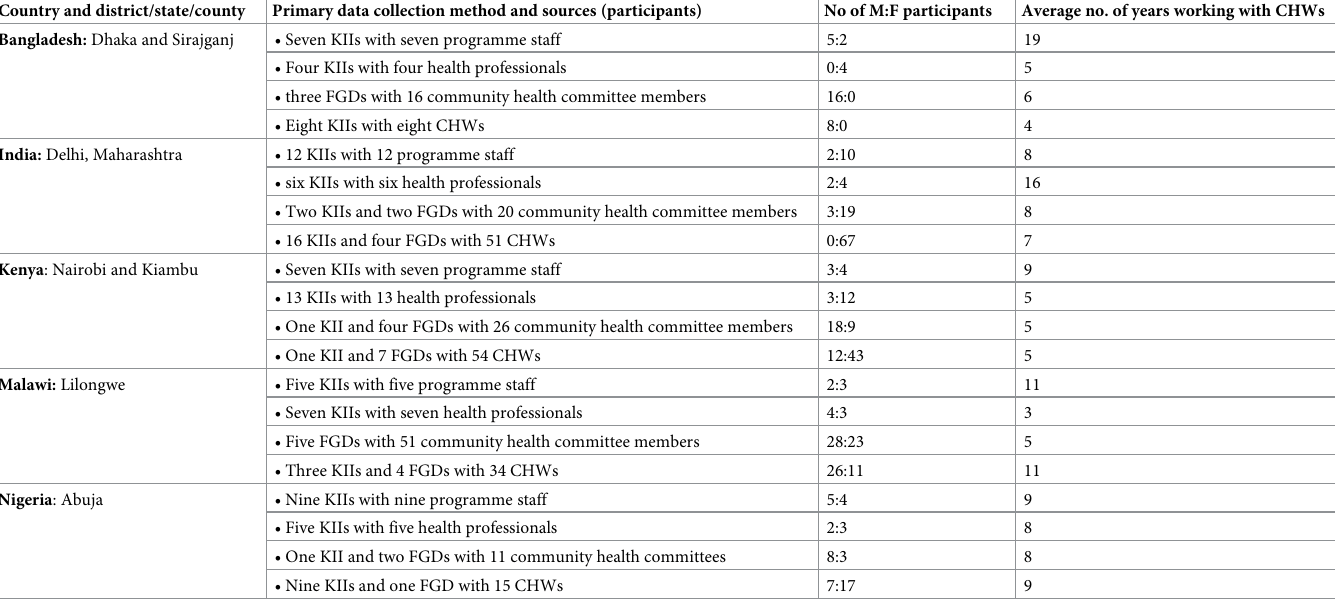
Table 1. Summary of data collection in study